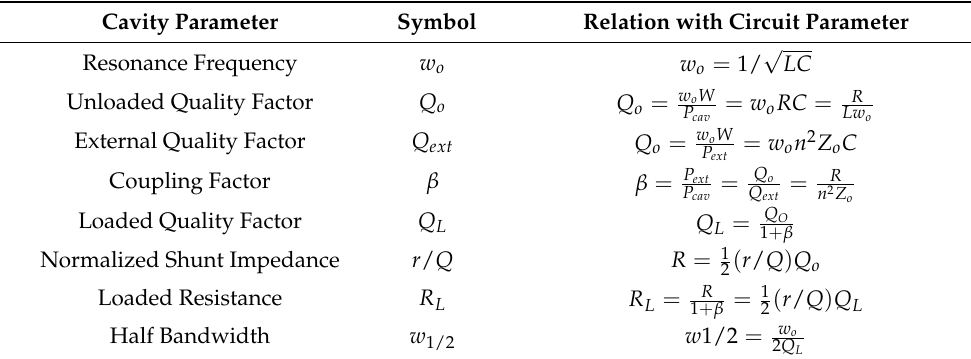
Table 1. Cavity circuit model parameters relations with typical cavity parameters. Cavity Parameter